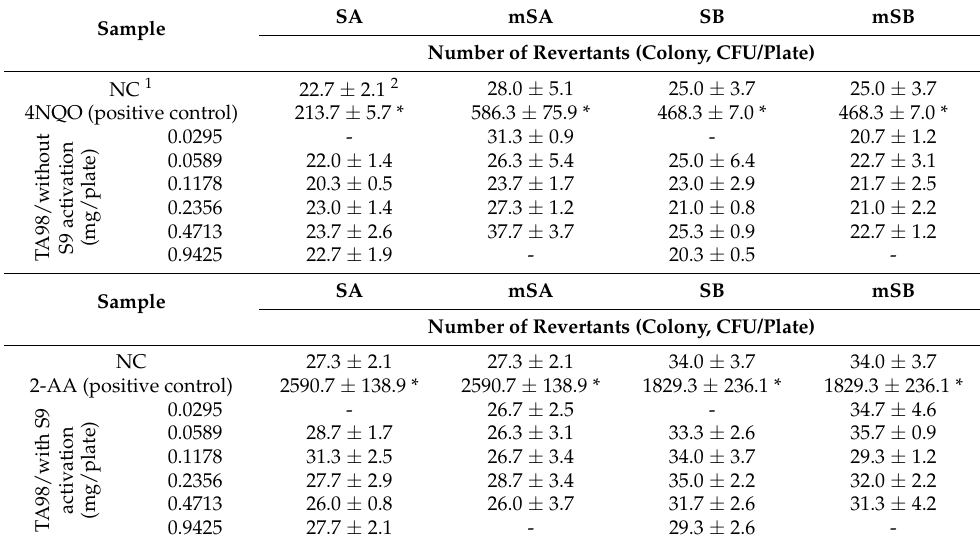
Table 4. Revertant changes of SA, mSA, SB, and mSB in Salmonella TA98 mutagenicity